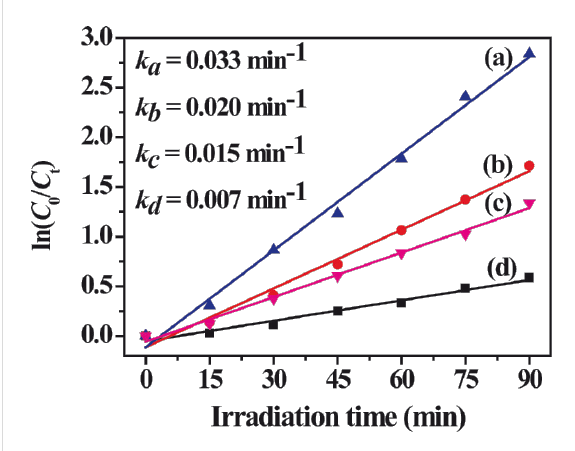
Figure 7: Photocatalytic degradation of MB aqueous solution over Ag 2 CrO 4 samples prepared by (a) microemulsion, (b) precipitation, and (c) hydrothermal methods, and (d) P25 sample under visible-light irradiation.